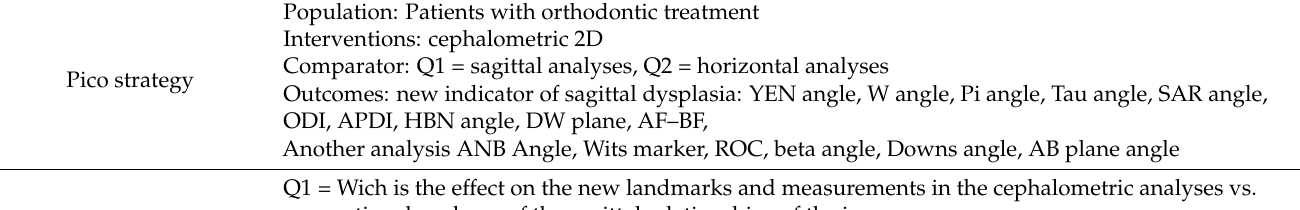
Table 1. The algorithms used in the search strategy updated for each database and